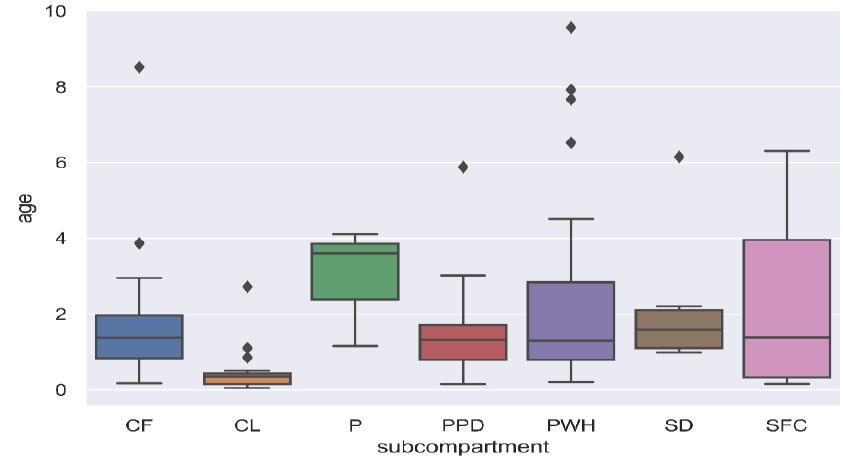
Figure 5. Subcompartment boxplot of the ages of the samples; CP: Coastal Plains; CL: Coastal Lowland; P: Plateau; PPD: Paulista Peripheral Depression; PWP: Paulista Western Plateau; SD: Sertaneja Depression; SFC: São Francisco Craton.